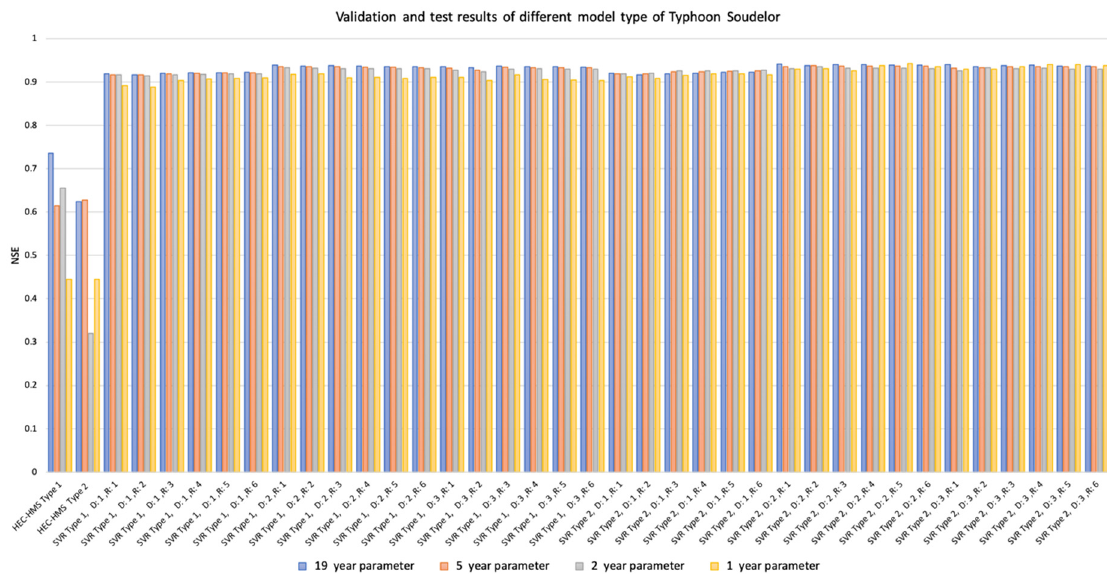
Figure 10. The NSE of the SVR and HEC-HMS models validation and test using different approaches for Typhoon Saola.